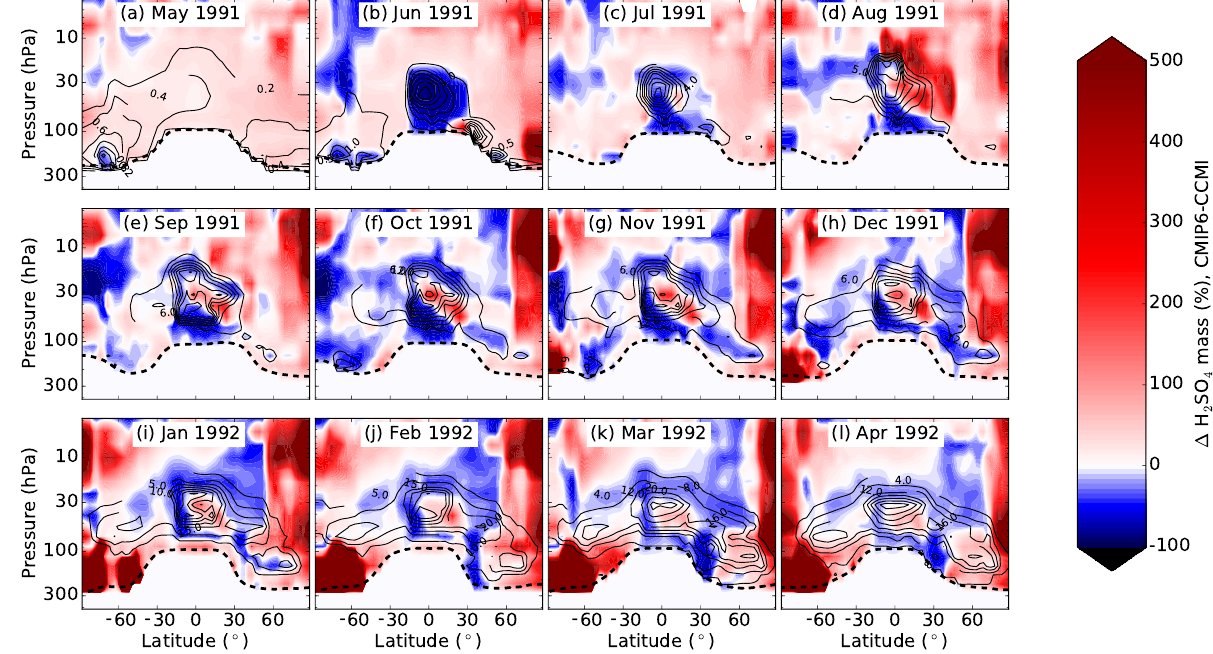
Figure 1. Percentage difference in H 2 SO 4 aerosol mass in the CCMI and CMIP6 stratospheric aerosol data sets for 12 months around the Mt Pinatubo eruption in June 1991, CMIP6 minus CCMI. Black contours show the CCMI H 2 SO 4 mass in 10 9 moleculescm − 3 . The dashed black line shows the location of the WMO-defined tropopause. Note that aerosol data are supplied down to 5km altitude in the CCMI and CMIP6 data sets, which are based on cloud-cleared SAGE II measurements, but these values are recommended for use only above the model